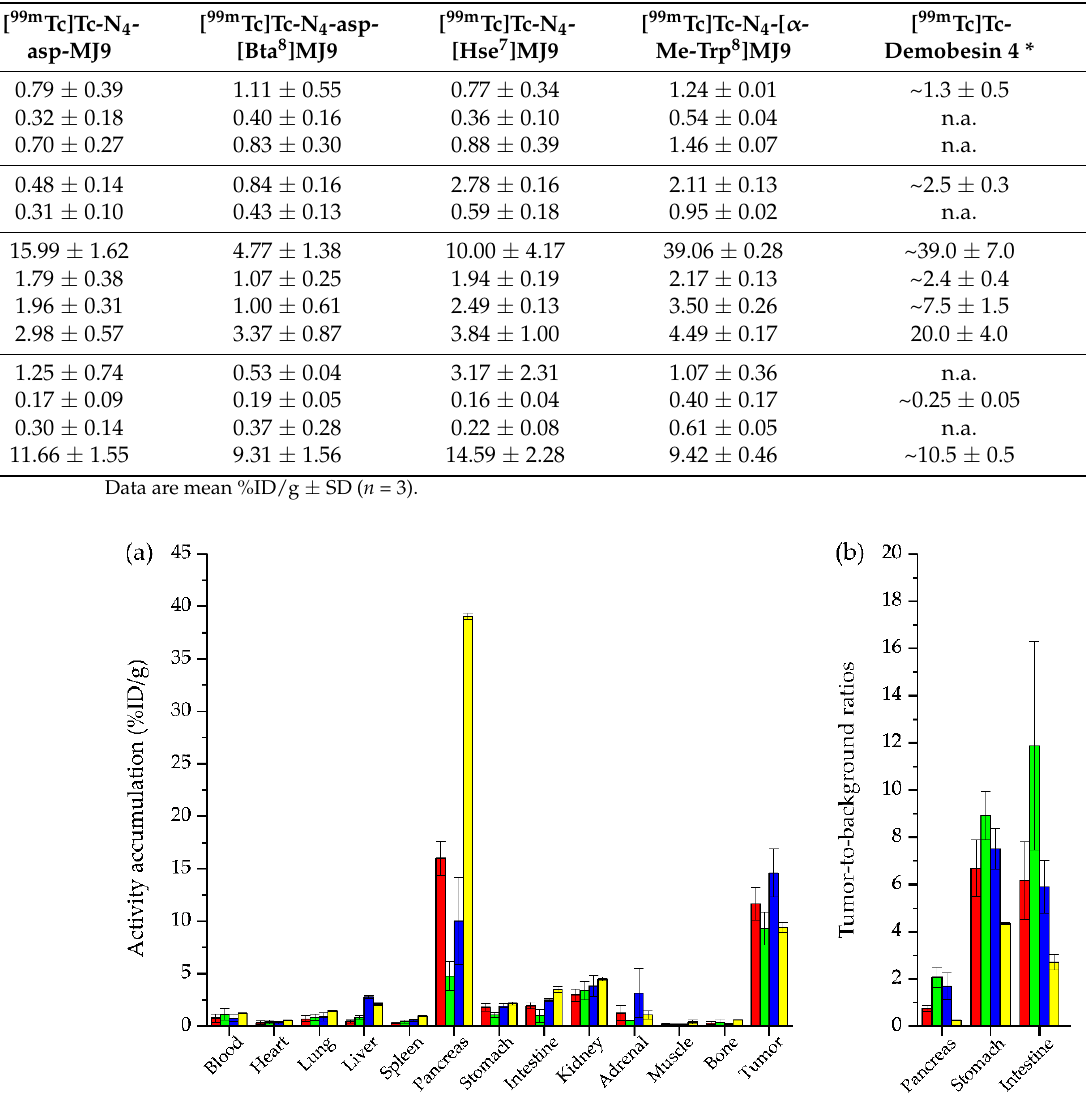
Figure 3. Biodistribution data of [ 99m Tc]Tc-N 4 -asp-MJ9 (red), [ 99m Tc]Tc-N 4 -asp-[Bta 8 ]MJ9 (green), [ 99m Tc]Tc-N 4 -[Hse 7 ]MJ9 (blue) and [ 99m Tc]Tc-N 4 -[ α -Me-Trp 8 ]MJ9 (yellow). ( a ) Biodistribution of the 99m Tc-labeled MJ9 derivatives (200 pmol each) in selected organs at 1 h p.i. in PC-3 tumor-bearing CB17-SCID mice. Data are %ID/g, mean ± SD ( n = 3). ( b ) Tumor-to-background ratios of the 99m Tc-labeled MJ9 derivatives for selected organs at 1 h p.i. in PC-3 tumor-bearing CB17-SCID mice. Data are mean ± SD ( n =